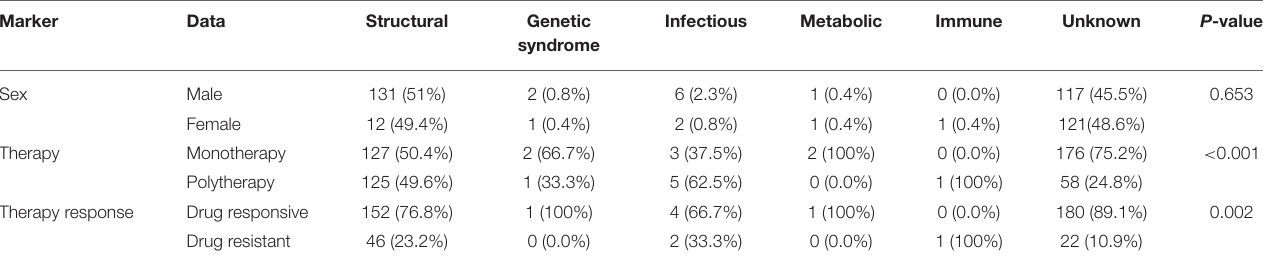
TABLE 4 | Clinical data and the type of seizure in individuals with epilepsy from a Brazilian University hospital from January 2010 to March 2021. Marker